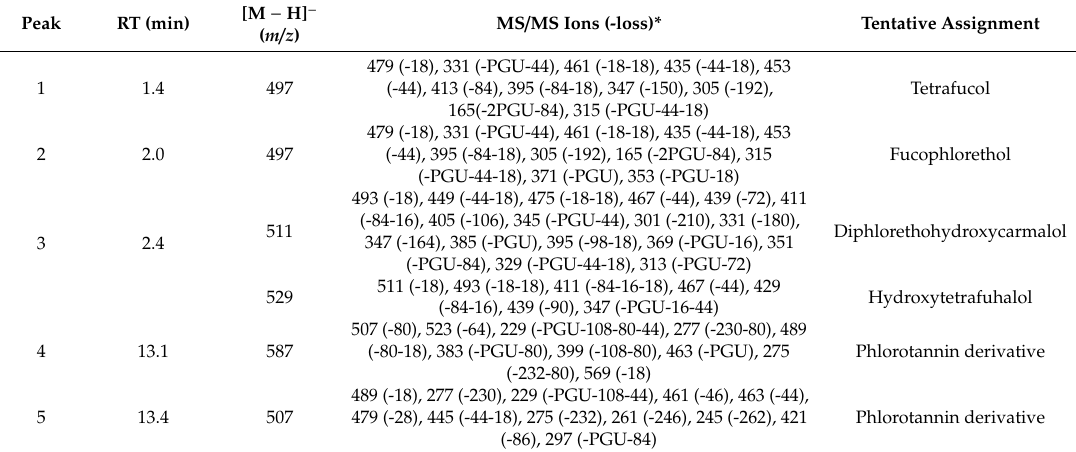
Table 2. Tentative assignment of the compounds detected in the F2 analyzed by UHPLC-ESI-MS / MS.